Question: Express in one sentence what the figure is showing.
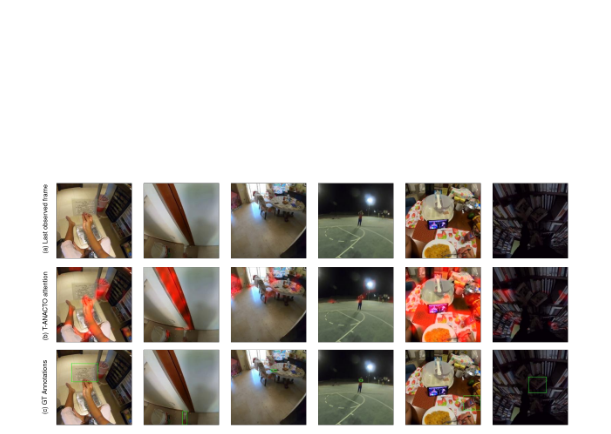
Answer: In the figure, we report results for some of the failure cases of our model as discussed in Section 8.2 for Ego4D dataset. (a) The model fails to attribute for higher TTC time for a given next active object. (b) For objects which are tiny or transparent or scattered around multiple objects it is difficult to identify next active object for larger TTC.